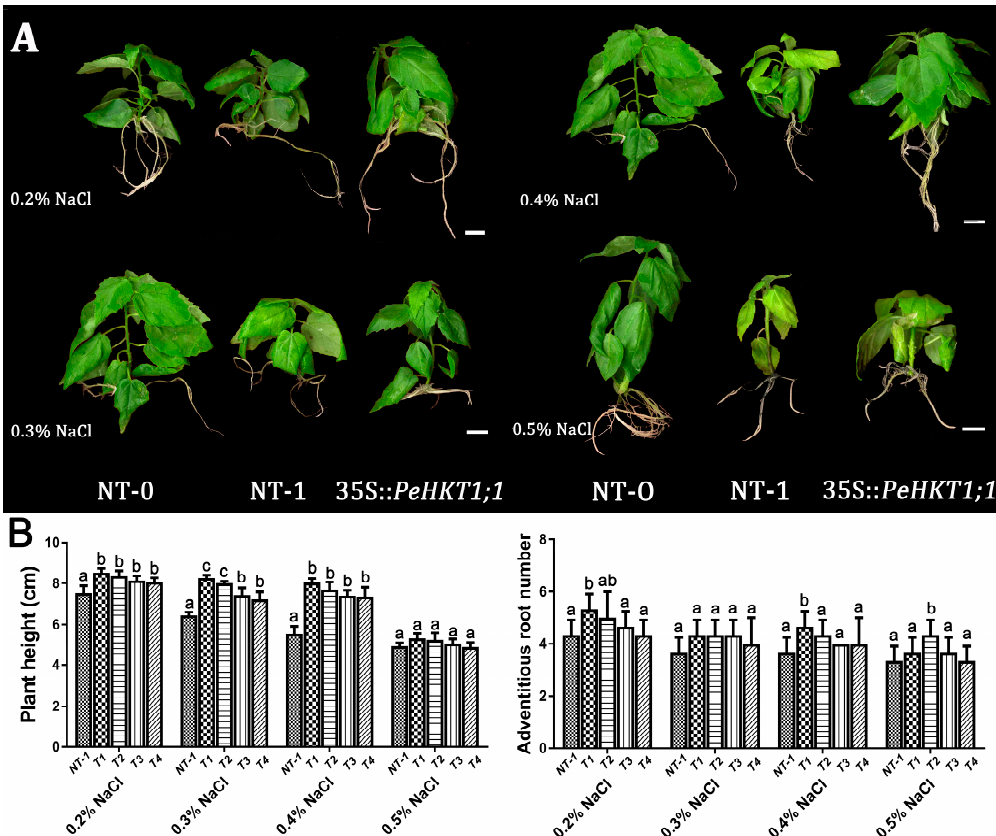
Figure 5. Phenotypes of NT poplar and PeHKT1;1 transgenic lines under salt stress conditions. Six-week-old non-transgenic (NT) and four transgenic poplar lines (T1, T2, T3, and T4) were treated with 0.2, 0.3, 0.4, and 0.5% w / v NaCl for two weeks. ( A ) Phenotypic observation of NT and transgenic poplar lines. The unstressed NT poplar (NT-0) were the positive control and NaCl-treated NT poplar (NT-1) was the negative control. All treatments had three biological replicates. Scale bar represents 1 cm. ( B ) The statistical analyses of plant height and adventitious root number. Data were analyzed using one-way ANOVA followed by Duncan’s test. Error bars with letters represent significant differences ( p < 0.05, Duncan’s